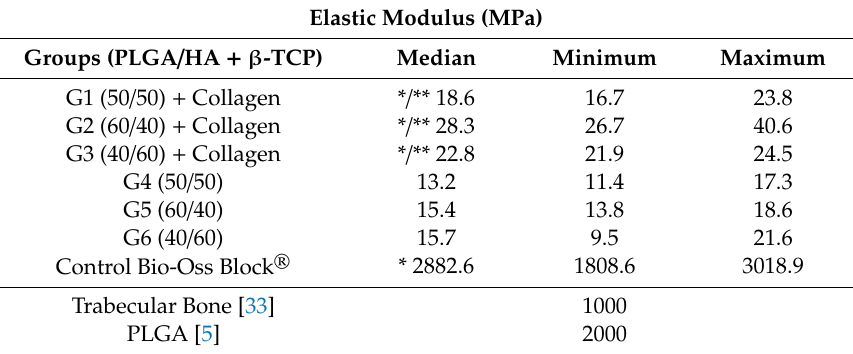
Table 4. Elastic modulus values in the composite and control groups. There was a statistically significant difference between the composites and control group. Moreover, statistical analysis revealed a significant differenceintheelasticmodulusbetweengroupswith(G1, G2, andG3)andwithoutcollagenimpregnation (G4, G5, and